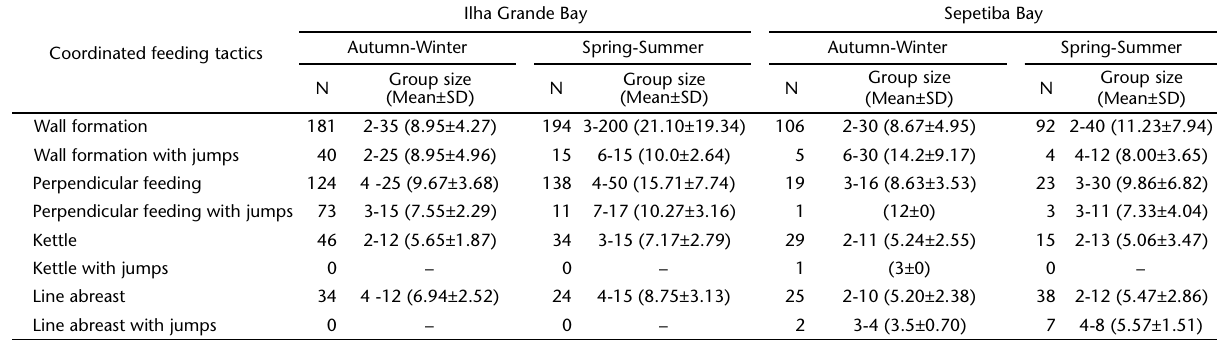
Table II. Number of occurrences (N) and group size engaged in each tactic during the two sampling periods in Ilha Grande Bay (retrieved from T ARDIN et al. 2011) and Sepetiba Bay.